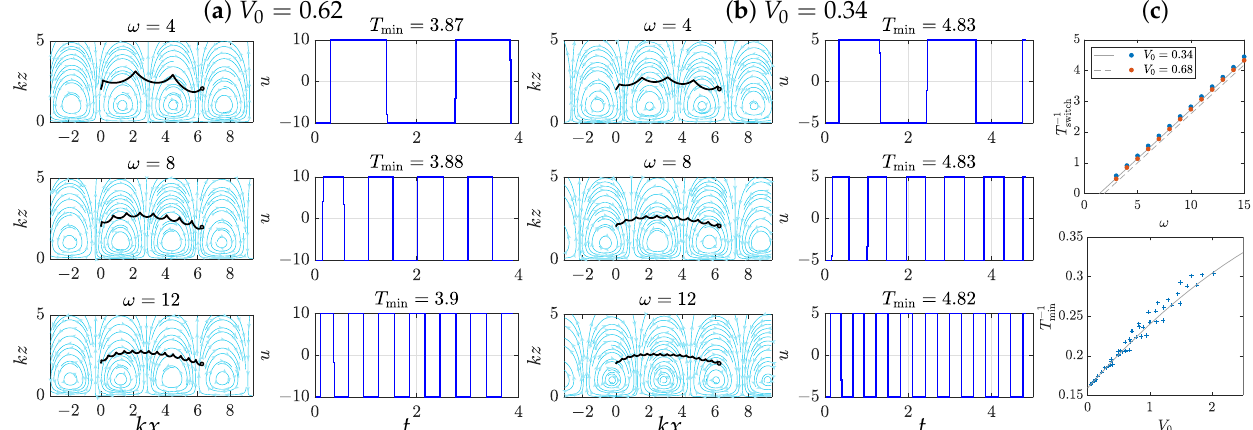
Figure 3. Visualisation of the time-optimal trajectories for a displacement parallel to the wall with units of k = v = 1. Panels ( a , b ) display various trajectories obtained by solving the optimal control problem, with the swimmer going from x 0 = 0 to x 1 = 2 π / k . On each pair of graphs, the left panel shows the path of the swimmer within the flow field, and the right panel shows the value of the control along time, with periodic switches. The trajectories for three different frequencies ω ( ω = 4,8,12) are displayed along with two different values of the characteristic speed V 0 (0.62 and 0.34, respectively, on panels ( a , b ), nondimensionalised with respect to the swimmer speed v ). The top graph of panel ( c ) shows the relationship between the control switch time T switch and the frequency ω . The blue and red dots correspond to numerically observed values, while the lines plot the expression obtained in Equation (15). The bottom plot shows the relationship between V 0 and the optimal time T min . The dots show the numerical values obtained with various values of V 0 (varying z 0 and u max ), and the line is the prediction given by Equation (16), showing remarkable